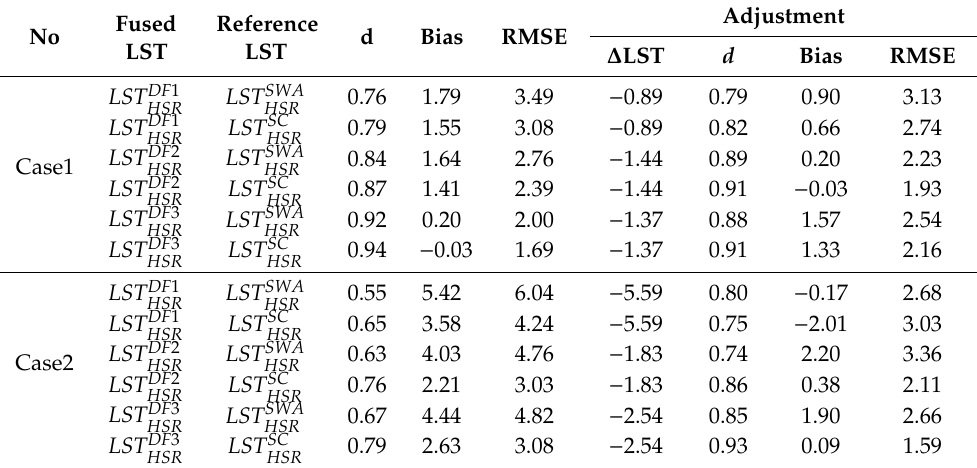
Table 4. The comparisons between reference LSTs and the fused LSTs before and after adjustments. No